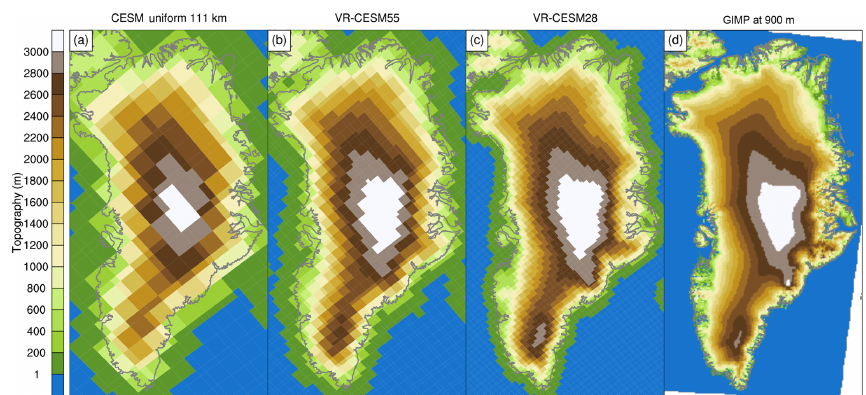
Figure 2. Topographic height in the three CESM simulations. For plotting purposes, spectral element node heights are displayed on control volumes equal to the area that they represent. The control volumes are identical to those used by the CESM coupler to conserve mass and energy. For reference, topographic height according to the Greenland Ice Mapping Project (GIMP; Howat et al., 2014) is shown, which has been upscaled to